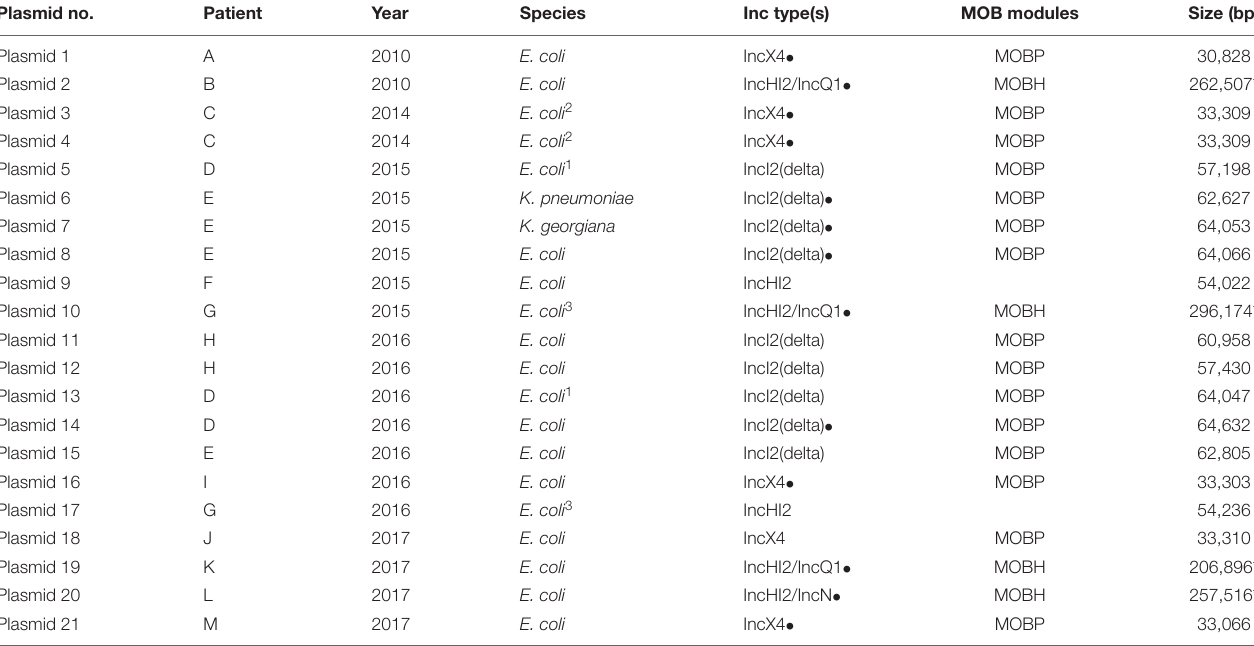
TABLE 1 | Plasmids carrying mcr-1 present in the patient isolates. Plasmid no.